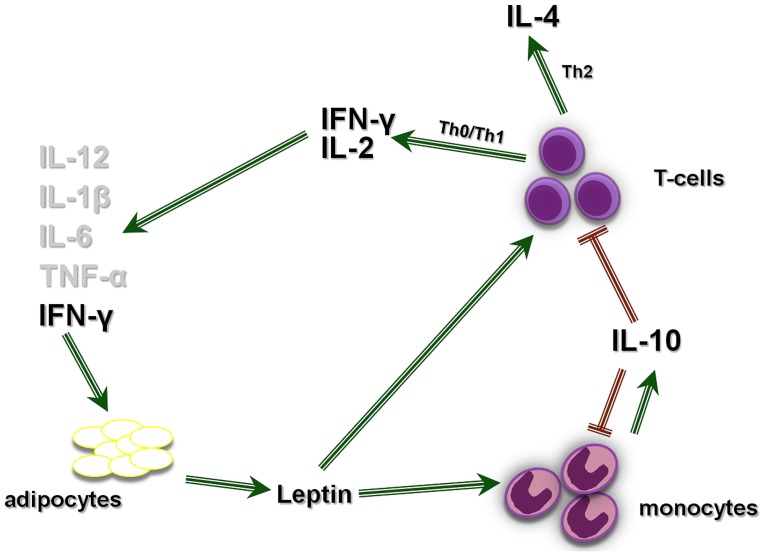
Proposed model of leptin regulation of cytokine production by cord blood T-cells and monocytes.Leptin is produced by adipocytes (and other tissues including the placenta), binds to its receptor (OB-R) on T-cells and monocytes [29], and directly activates them to express cytokines. T-cells express the Th0/Th1 cytokine genes IFN-γ and IL-2 and the Th2 cytokine gene IL-4, that mediate effector functions [57], and monocytes express IL-10, a main anti-inflammatory cytokine that limits the immune response and prevents damage to the host [58]. In infants with very high leptin levels, leptin stimulation of IFN-γ production by T-cells overrides IL-10 production by monocytes [59]; in this milieu, a Th1 response predominates; in addition, IFN-γ may enhance cytokine stimulation of leptin synthesis by adipocytes [51], [52], [60], [61], [62] and perpetuate the Th1 polarization.